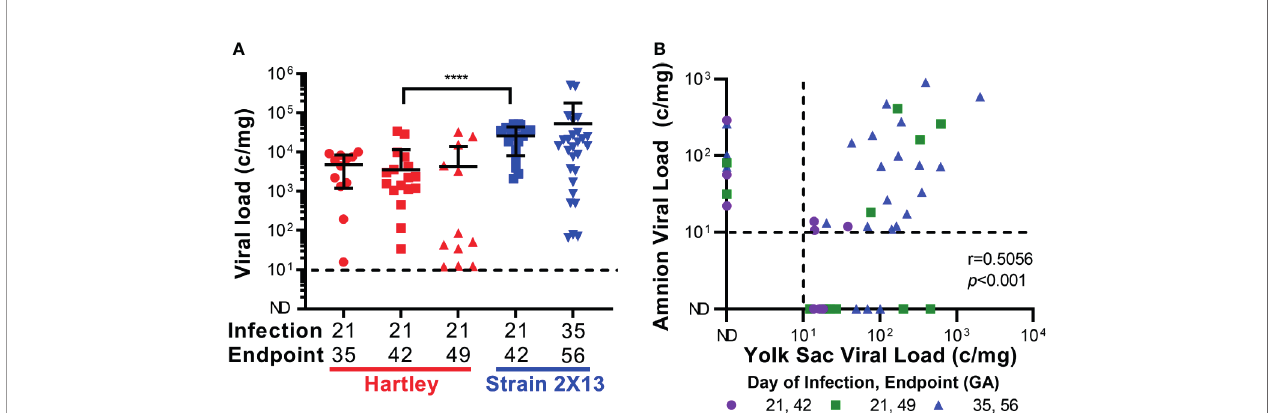
FIGURE 2 | GPCMV viral loads after maternal infection during pregnancy. Time mated guinea pigs were infected at either 21 or 35 dGA with 2X10 5 PFU of GPCMV and euthanized 14, 21, or 28 days later. DNA was extracted from tissues and GPCMV viral loads were determined using a ddPCR assay speci fi c to GP54. The limit of detection for this assay is indicated by the dashed line. (A) Viral load in placentas. Signi fi cantly higher viral loads (Mann-Whitney test, **** p < 0.0001) were observed in the placentas of strain 2X13 hybrids than in the placentas of Hartley guinea pigs. (B) Viral loads in infected fetal membranes. The number of GPCMV genome copies detected in the amnion and visceral yolk sac of individual fetuses was signi fi cantly correlated (Pearson r=0.5056, p < 0.001).